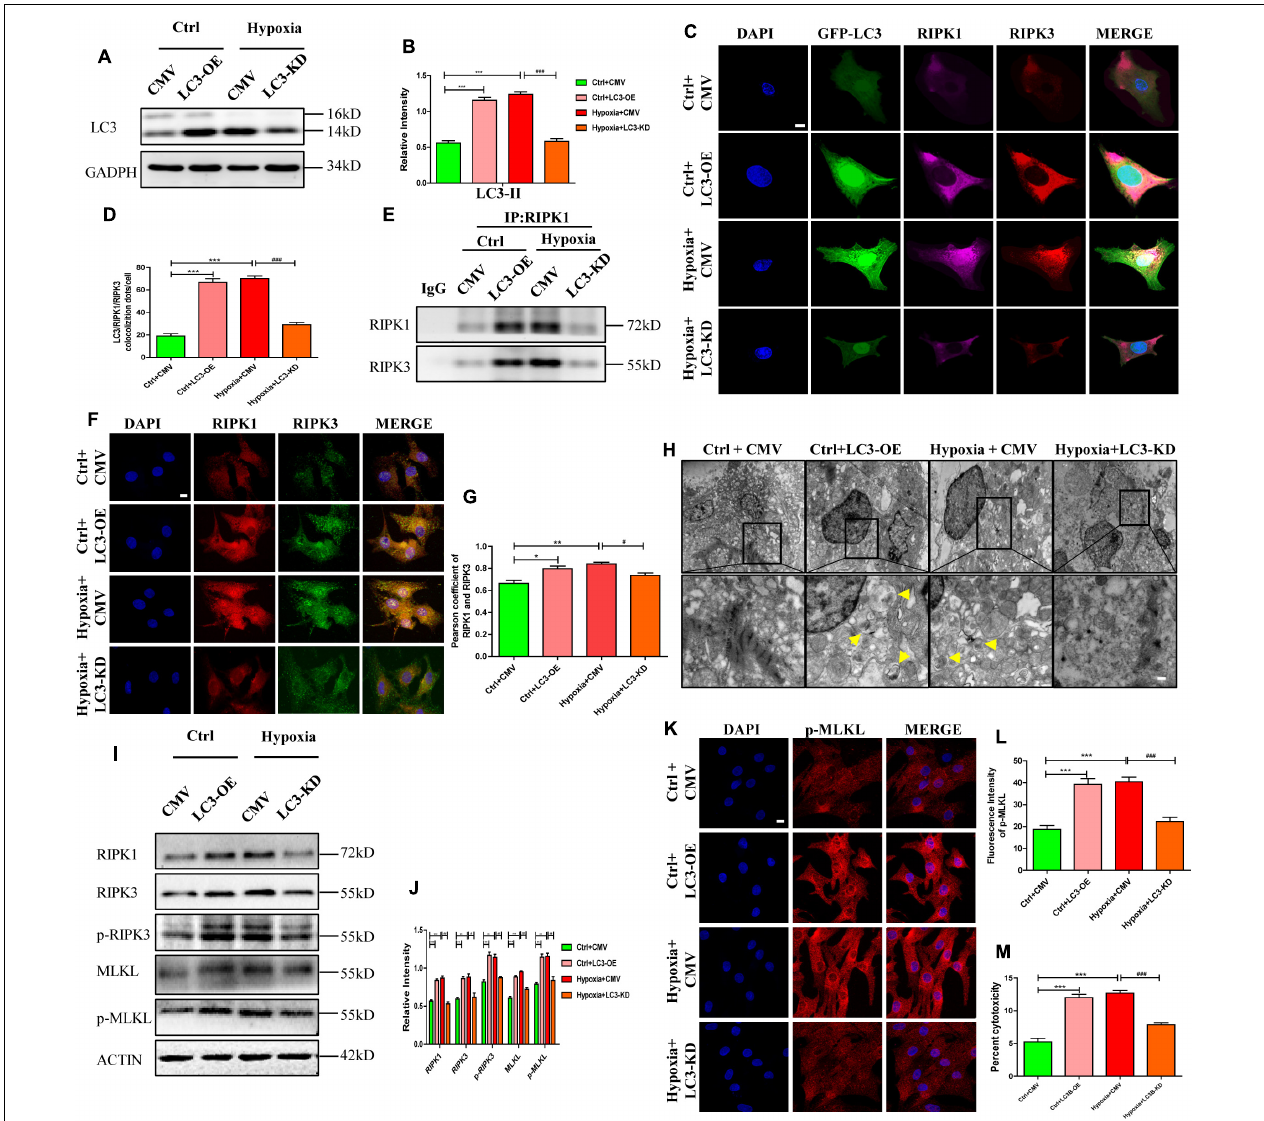
FIGURE 5 | RIPK1 and RIPK3 augmentation induced by autophagosome accumulation facilitates necroptosis under hypoxic conditions. (A,B) Infection efficiency of LC3 overexpression (OE), LC3 knockdown (KD), and MCMV-null adenoviruses were determined by western blotting. Mean ± SEM, n = 3. *** p < 0.001 versus the control+CMV group. ### p < 0.001 versus the hypoxia+CMV group. (C,D) Co-localization and statistical analysis of LC3, RIPK1 and RIPK3 in groups from panel (A) . Mean ± SEM, *** p < 0.001 versus the Ctrl+CMV group, ### p < 0.001 versus the Hypoxia+CMV group Scale bar, 10 µ m, n = 3. (E) After regulating autophagy with LC3 overexpression or knockdown adenovirus under normoxia or hypoxia, protein samples were collected from cardiomyocytes and immunoprecipitated with anti-RIPK1 antibodies, followed by immunoblotting with anti-RIPK1 or anti-RIPK3 antibody ( n = 5). (F,G) Co-localization and statistical analysis of RIPK1 and RIPK3 in groups from panel (A) . * p < 0.05 and ** p < 0.001 versus the Ctrl+CMV group, # p < 0.05 versus the Hypoxia+CMV group. Scale bar, 10 µ m, n = 3. (H) Representative images of autophagosomes in corresponding groups in panel (D) . Yellow arrow points to an autophagosome. Scale bar, 0.5 µ m, n = 3. (I,J) Western blotting and statistical analysis of RIPK1, RIPK3, p-RIPK3, MLKL, and p-MLKL from Ctrl+CMV, Ctrl+LC3-OE, Hypoxia+CMV, and Hypoxia+LC3-KD groups ( n = 3). Mean ± SEM. * p < 0.05, ** p < 0.01, *** p < 0.001 versus the Ctrl+CMV group, # p < 0.05 and ## p < 0.01 versus the Hypoxia+CMV group. (K,L) Representative confocal images and statistical analysis of p-MLKL in corresponding groups in panel (A) . Mean ± SEM. *** p < 0.001 versus the Ctrl+CMV group, ### p < 0.001 versus the Hypoxia+CMV group. Scale bar, 10 µ m, n = 3. (M) Lactate dehydrogenase (LDH) leakage analysis was performed to determine cell death. Mean ± SEM, n = 5. *** p < 0.001 versus the Ctrl+CMV group, ### p < 0.001 versus the Hypoxia+CMV